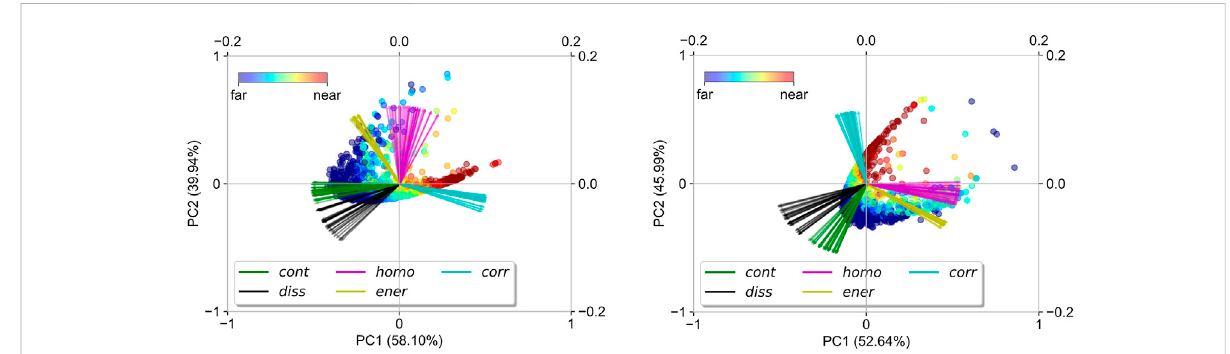
FIGURE 2 Biplots obtained by principal component analysis (PCA) of the standardized GLCM features ’ table illustrate variabilities in GLCM features extracted among reference peaks in datasets (A) and (B). The colors of the dots denote their distance from the X-ray photograph of the sediment slide.GLCMfeaturesaredenotedbyarrowsinthebiplots,andthearrowswiththesamecolordenotethesameGLCMpropertyderivedfromdifferent pixel pairs. cont = contrast ; homo = homogeneity ; corr = correlation ; diss = dissimilarity ; ener = energy